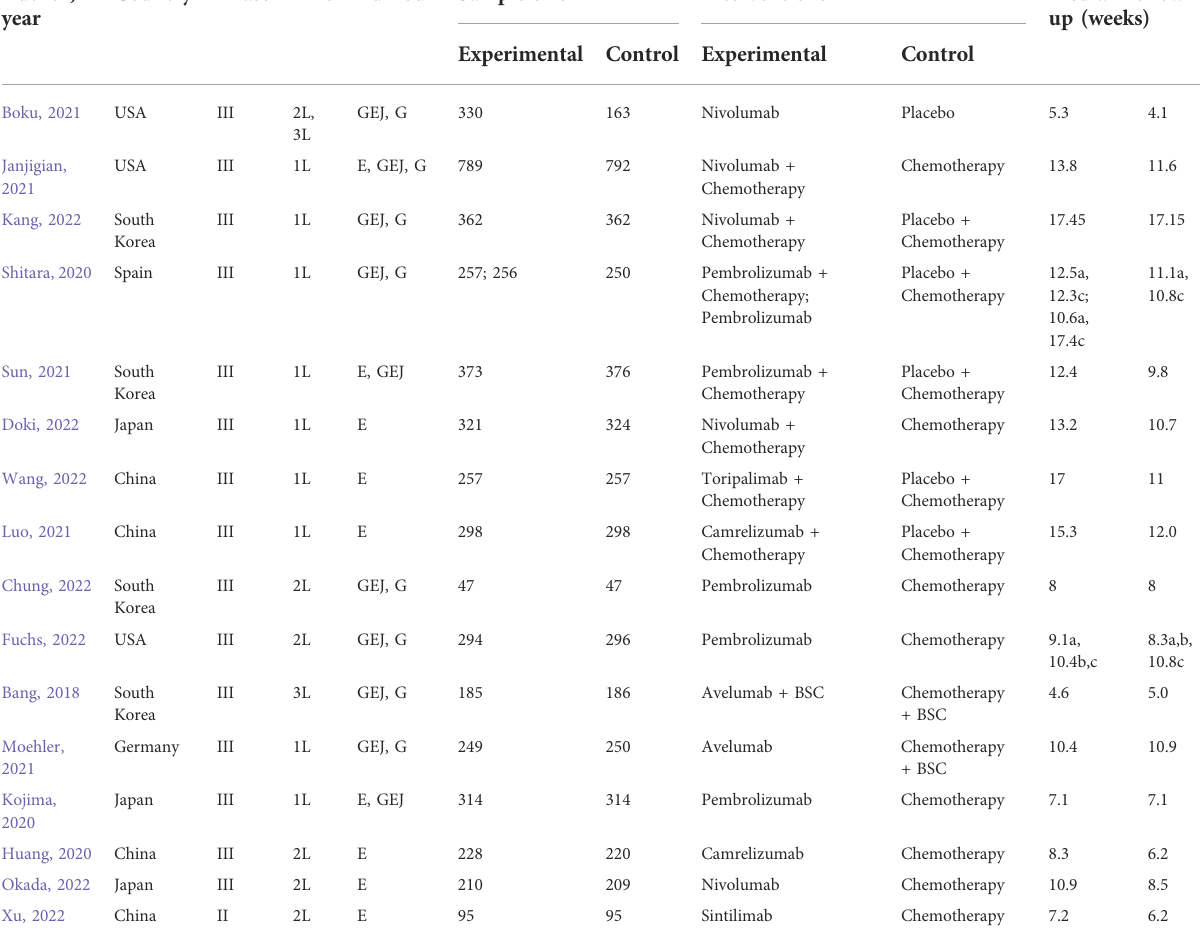
TABLE 1 The characteristics of studies included in this